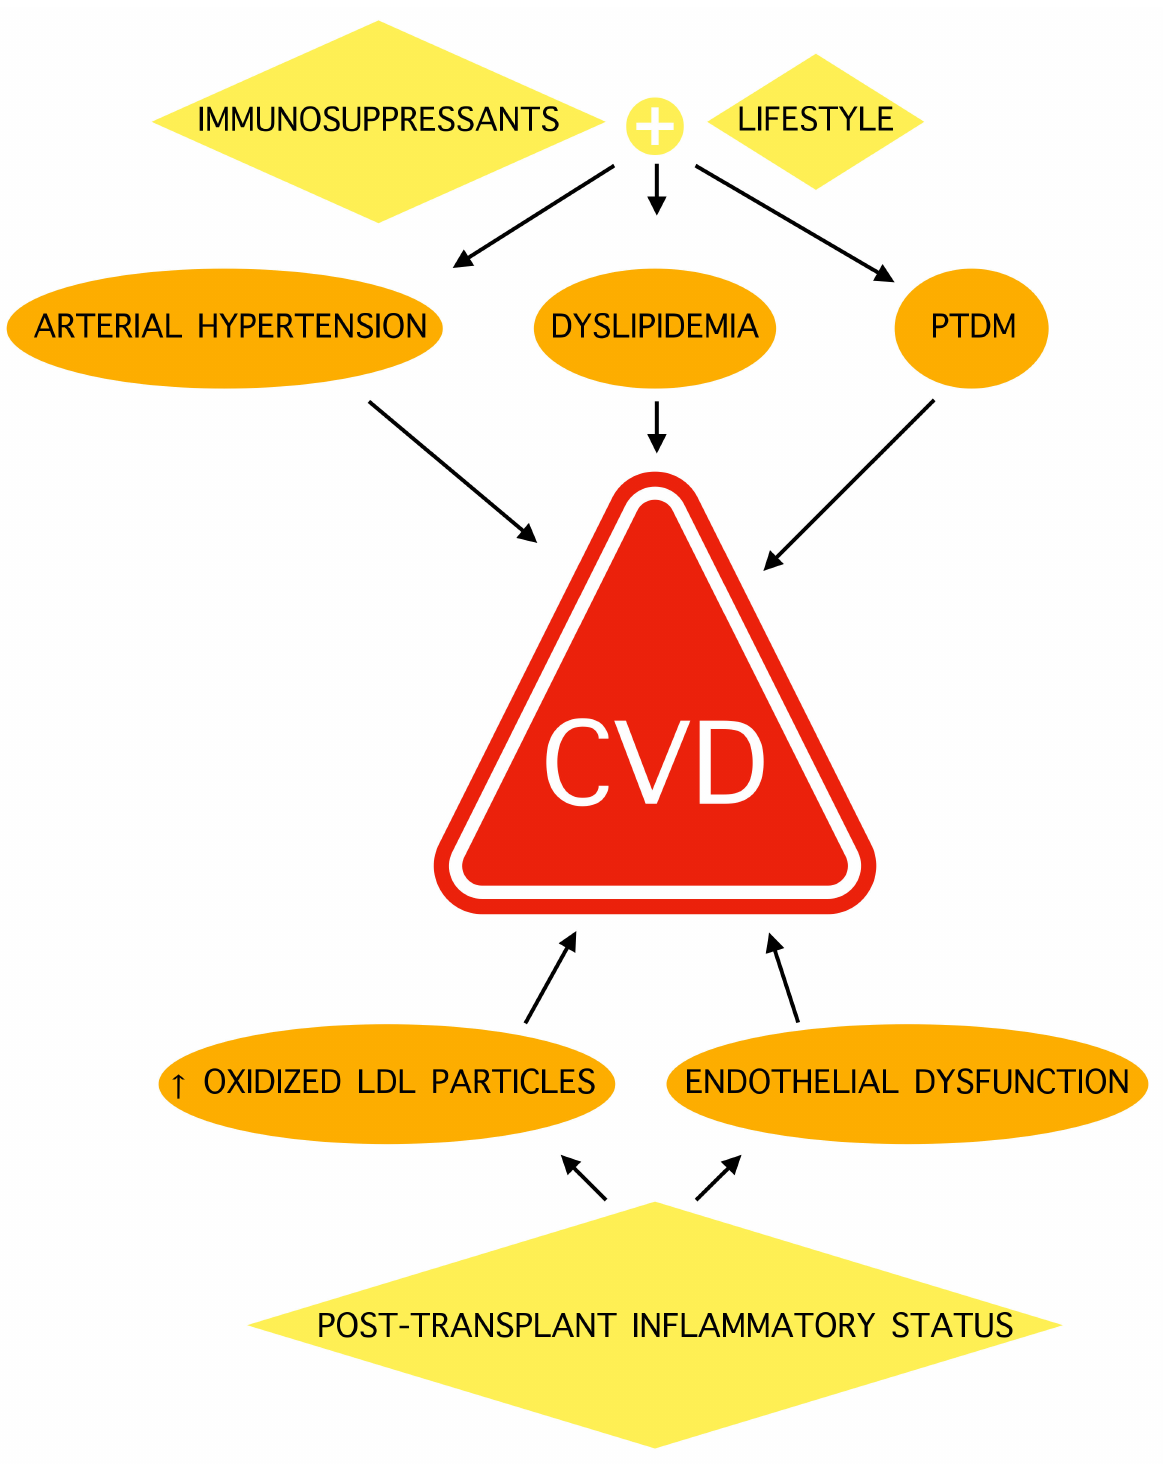
Figure 2. Cardiovascular disease mechanisms in transplant patients. CVD: cardiovascular disease; PTDM: post-transplant diabetes mellitus. LDL: low-density